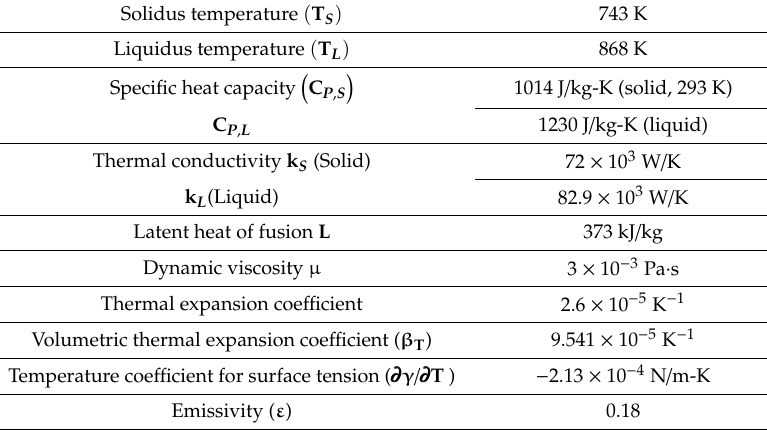
Table 3. Properties of AZ91D alloy (Friedrich and Mordike, 2006) [36].